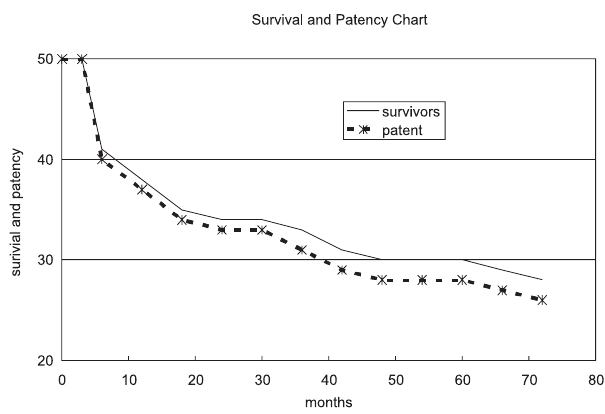
Figure 1 - Primary patency